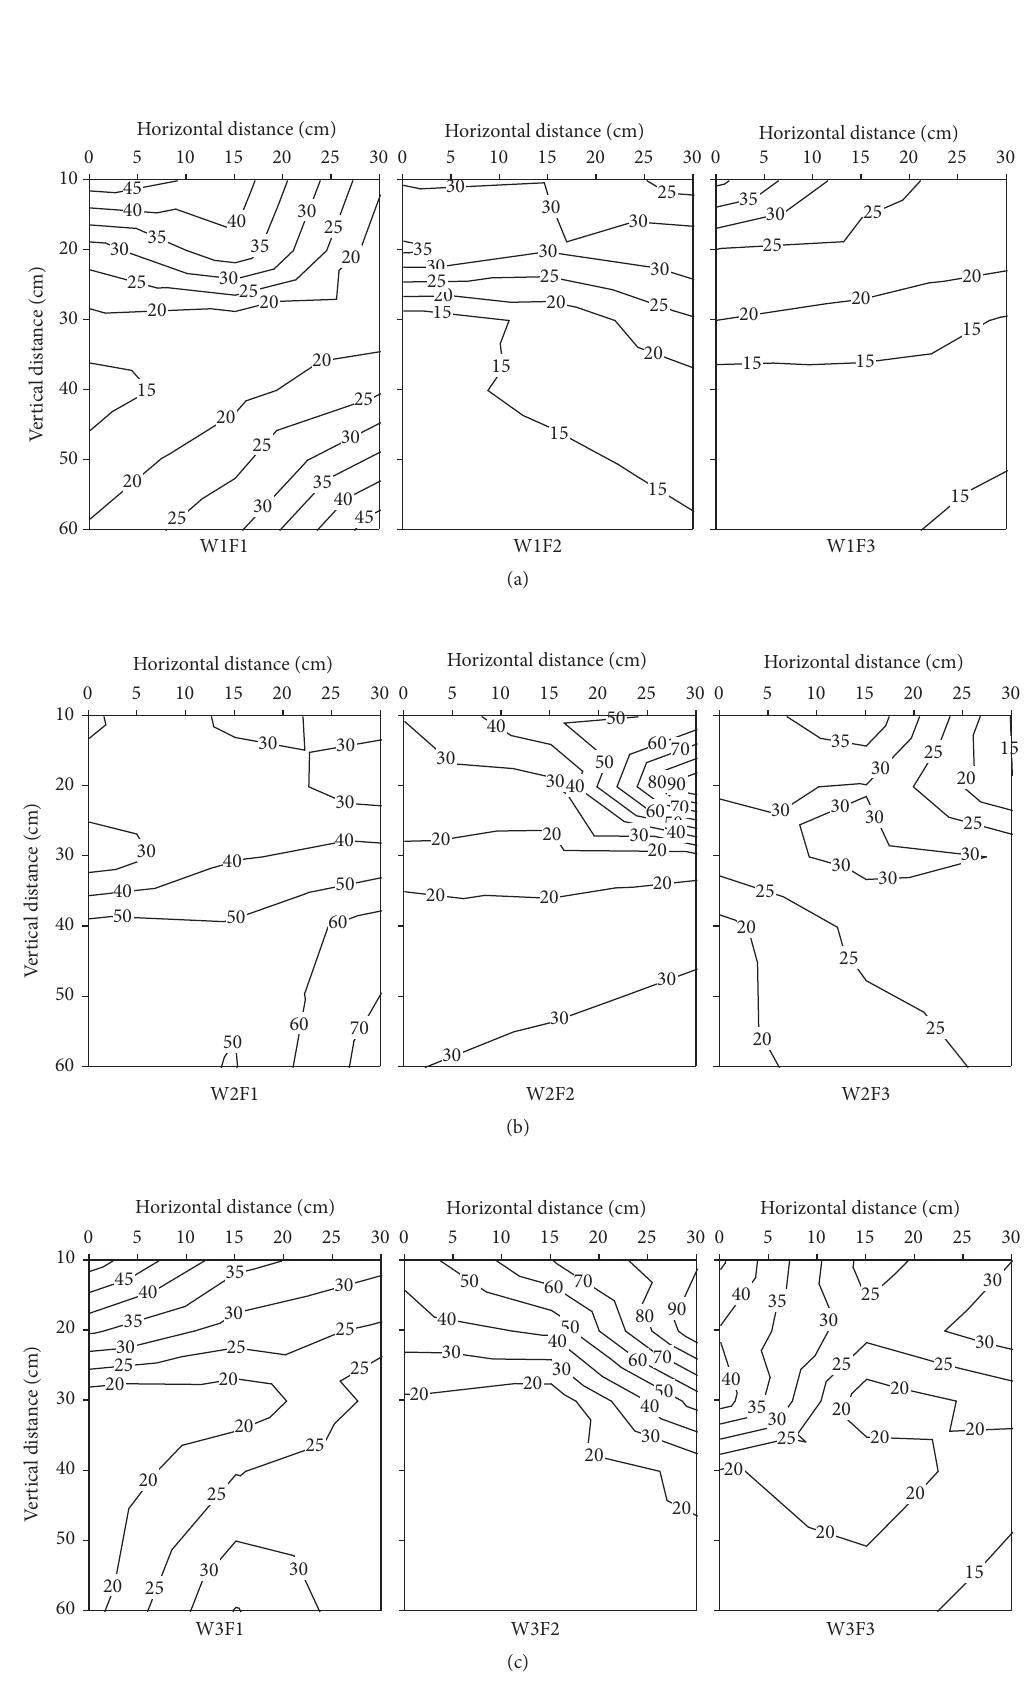
Figure 5: The effects of different irrigation and fertilization on vertical distribution of soil NO 3− -N content in root zone soil of different treatment at 59 days after transplanting in 2012. W1: 100% ET 0 , W2: 75% ET 0 , and W3: 50% ET 0 ; F1: N240–P 2 O 5 120–K 2 O150 kg hm −2 ; F2: N180–P 2 O 5 90–K 2 O112.5 kghm −2 ; and F3: N120–P 2 O 5 60–K 2 O75 kg hm −2